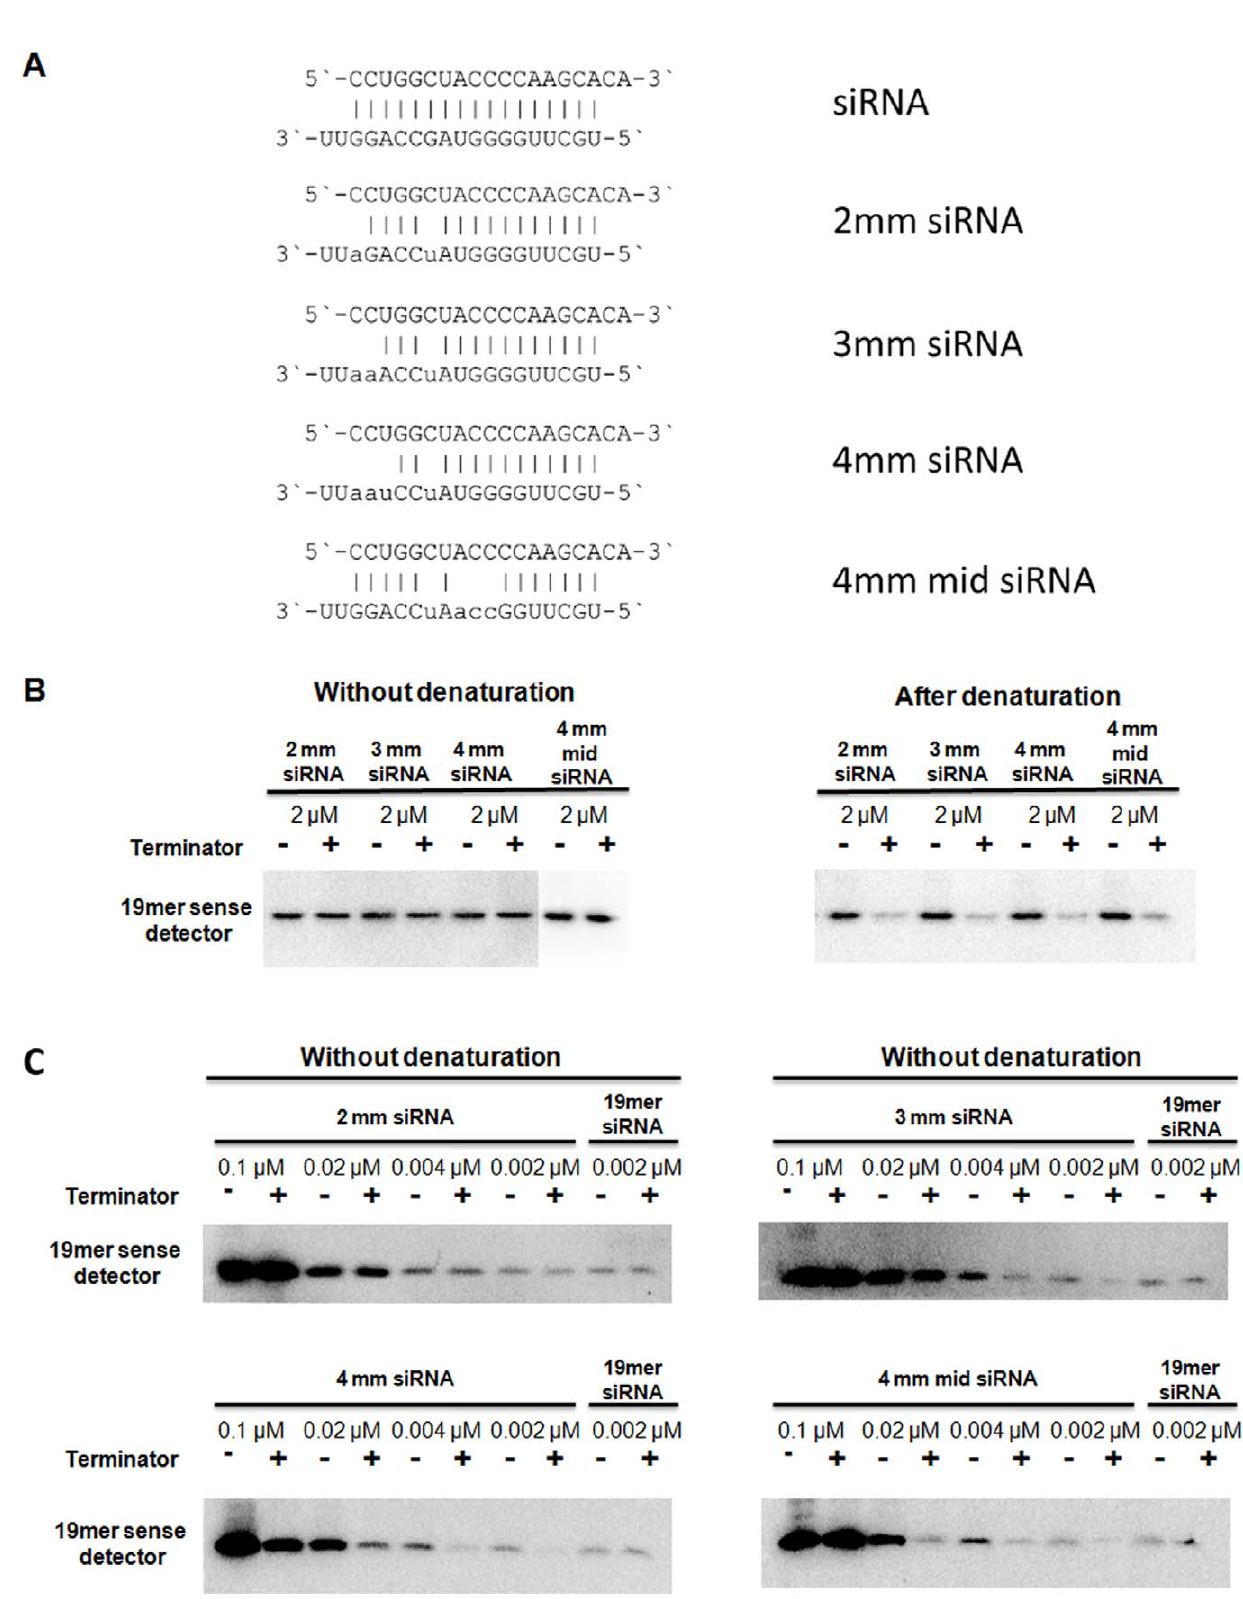
Figure 3. Terminator digest of imperfect duplexes. In vitro synthesised and phosphorylated imperfect RNA duplexes (A) were digested with Terminator TM 5 9 -Phosphate-Dependent Exonuclease at the concentration of 2 m M without (left panel) or after denaturation (right panel) (B). The efficiency of the digestion was monitored by northern blot assay using a probe complementary to the sense strand of the imperfect duplexes, which